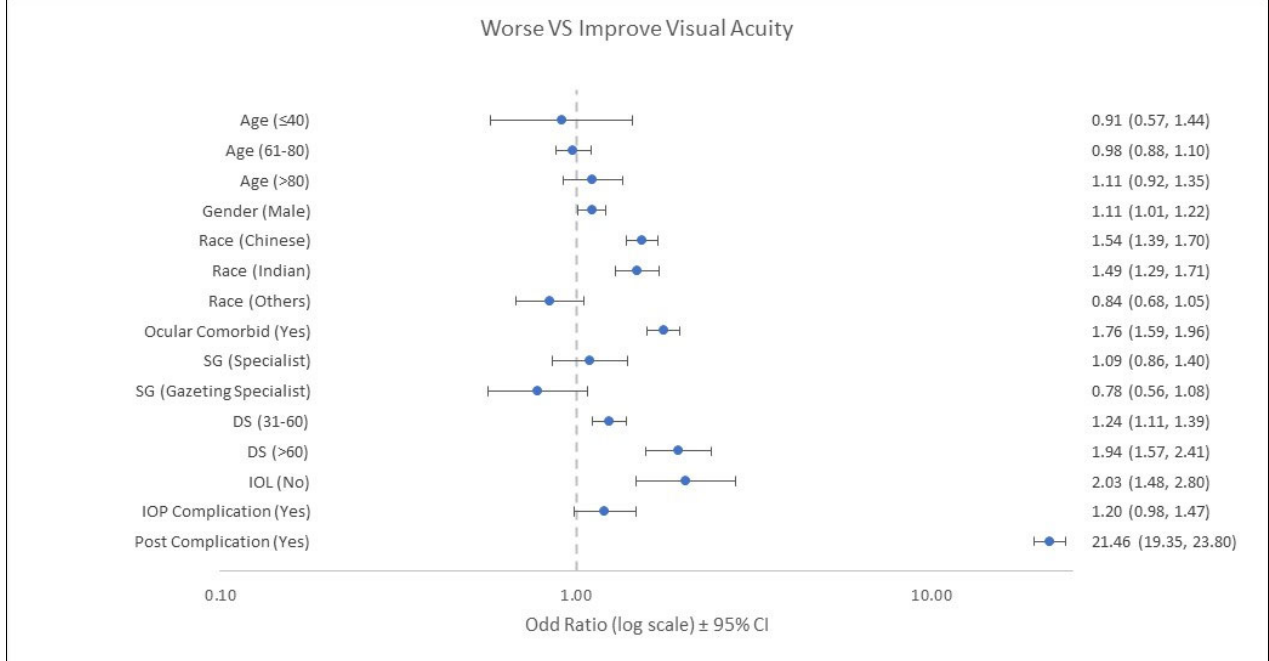
Figure 2. Forest plot of worsening VA versus improved VA (ref). Reference for age was 41–60 years old, gender was female, race was Malay, ocular comorbid was no, surgeon grade (SG) was medical officer, duration of surgery (DS) was ≤ 30 min, intraocular lens (IOL) was yes, intraoperative com ‐ plication (IOP) was no, and postoperative complication (Post) was no.